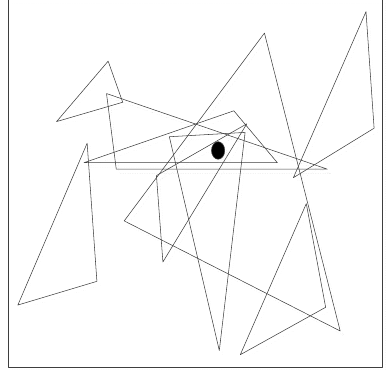
Figure 1. Principles of the APIT algorithm.